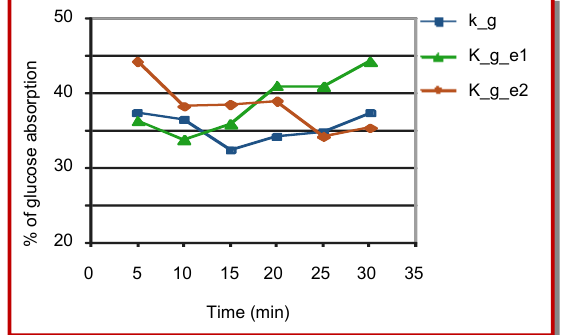
Figure 1: Effect of the M. indica on upper intestinal glucose absorp- tion on normal rats Results are presented as mean ± SD (n = 6). Rats were fasted for 36 hours and intestine was perfused with glucose solution (54 g/L) with or without ethanol extracts of M. indica (25 mg/mL). k_g= Krebs buffer supplemented with glucose; K_g_e1 = Ethanol extract of leaves; K_g_e2 = Ethanol extract of stem barks